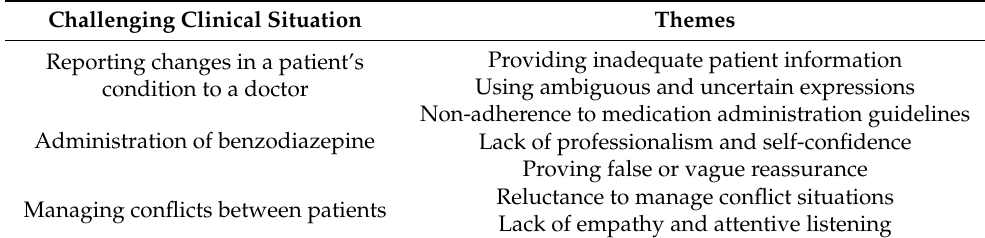
Table 1. Themes emerged in challenging clinical